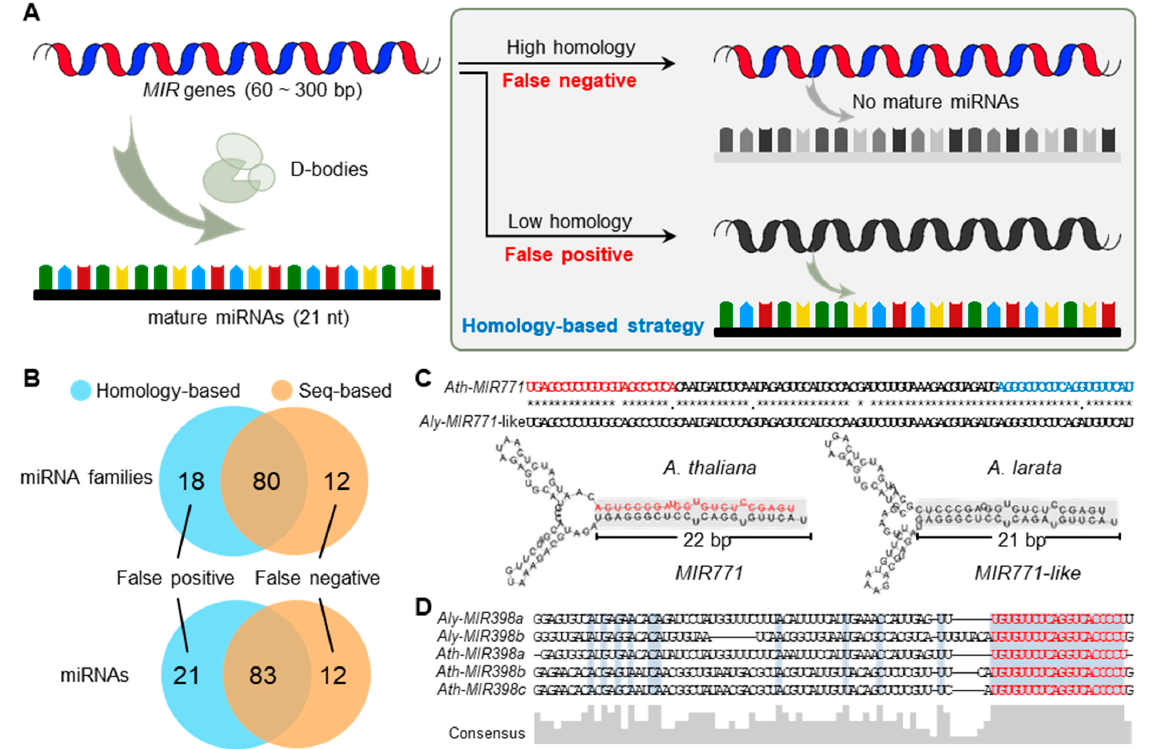
Figure 1. Comparison of homology-based and seq-based strategies for cataloging SS-miRNAs. ( A ) A schematic diagram showing a false negative and a false positive of SS-miRNAs caused by the homology-based strategy. ( B ) A comparison of the results of SS-miRNAs and SS-miRNA families in A. thaliana identified using the two strategies. ( C ) Sequence alignments and secondary structures, showing a false negative SS-miRNA family ( MIR771 ) mistakenly identified by the homology-based approach. Mature and star miR771 are highlighted in red and blue letters, respectively. The same nucleotides are marked in *. ( D ) Sequence alignments of the MIR398 family in A. thaliana and A. lyrate , showing a false positive SS-miRNA family in A. thaliana .